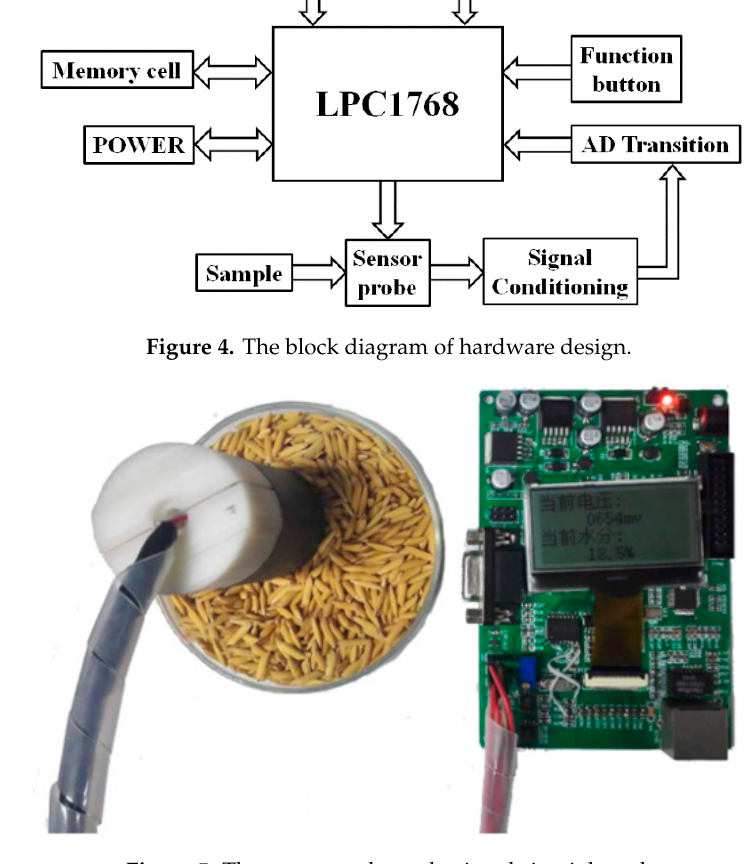
Figure 5. The sensor probe and printed circuit board.